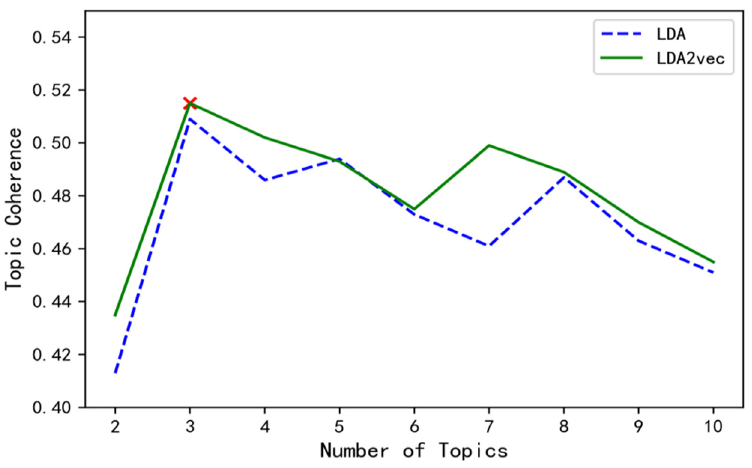
Figure 6. Topic coherence scores of the LDA and LDA2vec models.